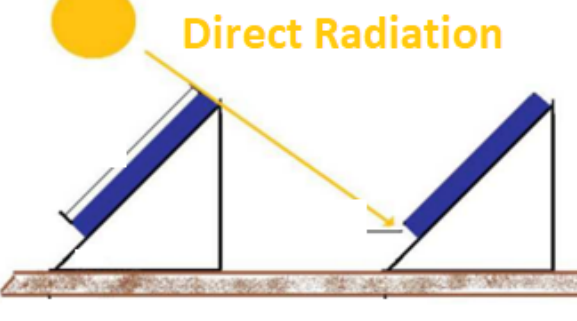
Figure 19. Example of a usual shading scenario on photovoltaic